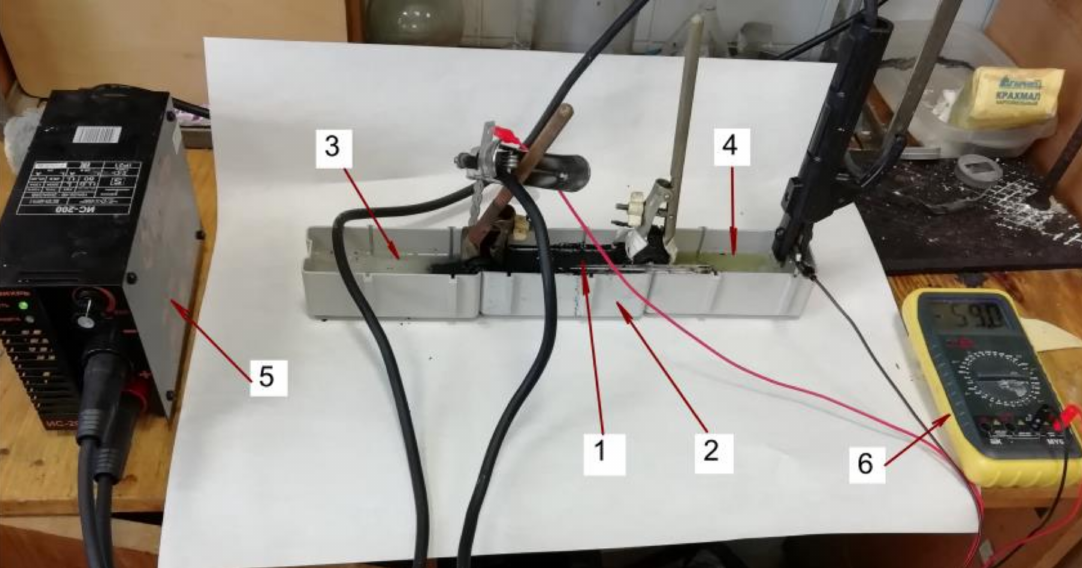
Figure 1. Sorbing electrochemical matrix (1—conductor, 2—reaction container, 3—catolyte (container with NaOH solution (3 mol / L)), 4—anolyte (container with the solution of NaOH (3 mol / L) with carbon anode), 5—direct current source, 6—multimeter).